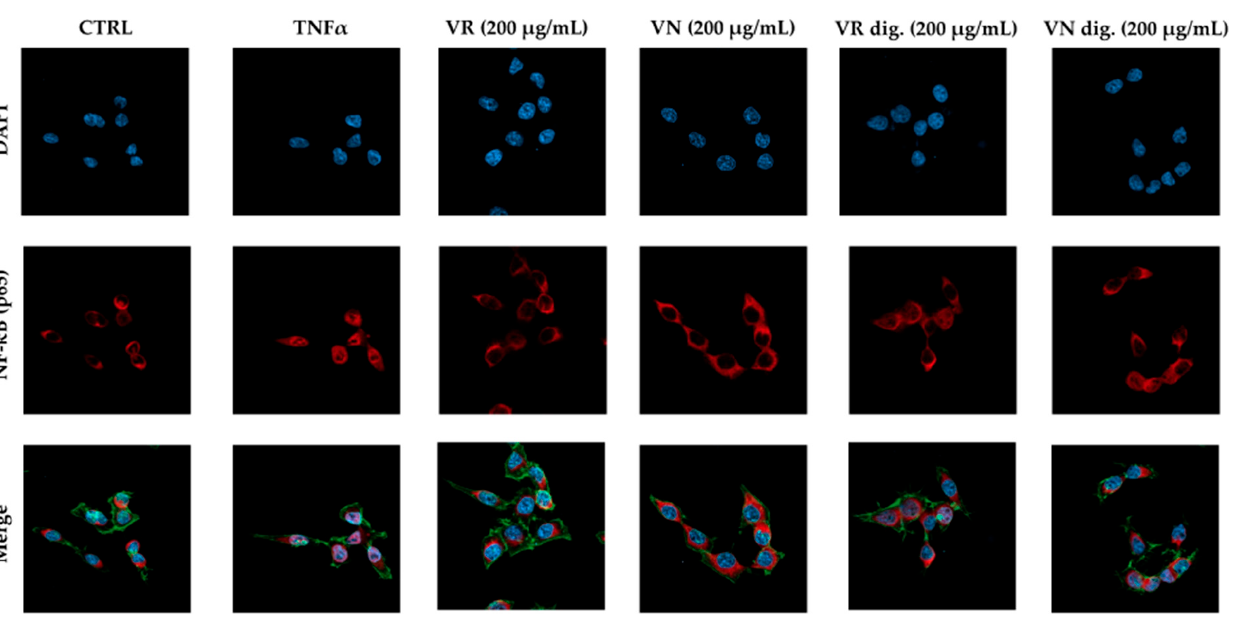
Figure 4. Effect of Castanea sativa Mill. leaf extracts on NF- κ B (p65) nuclear translocation induced by H. pylori . GES-1 cells were treated for 1 h with H. pylori (ratio 50:1, bacteria/cell) in addition to leaf extracts (200 µg/mL) before and after in vitro simulated digestion. NF- κ B (red) nuclear translocation from the cell cytoplasm into the nuclei (blue) was detected by confocal immunofluorescence microscopy (63× objective). Merged images include β -actin (green) and bacterial DNA (CFSE, white) staining. VR, Castanea sativa Mill. var. verdesa leaf extract; VN, Castanea sativa Mill. var. venegon leaf extract; dig., in vitro simulated digestion. In this case, we also confirmed the parallelism between the biological effects of the extracts and pure ellagitannins during H. pylori infection. As expected, castalagin and vescalagin impaired the nuclear translocation of p65 at the highest concentration responsible for the total inhibition of IL-8 release (50 µM) (Figure 5). The overall data